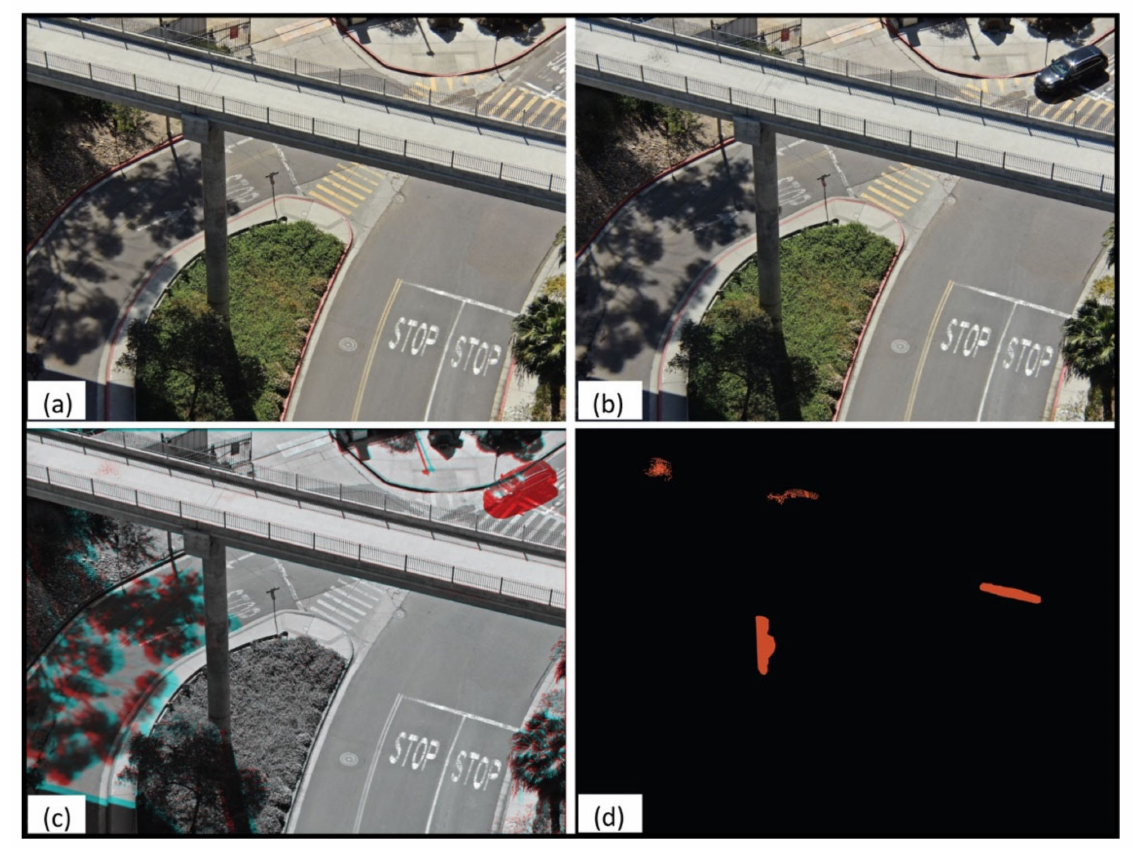
Figure 4. Example of pre-processing inputs ( a , b ) and outputs (layer-stack ( c ) and labels ( d )) used for machine